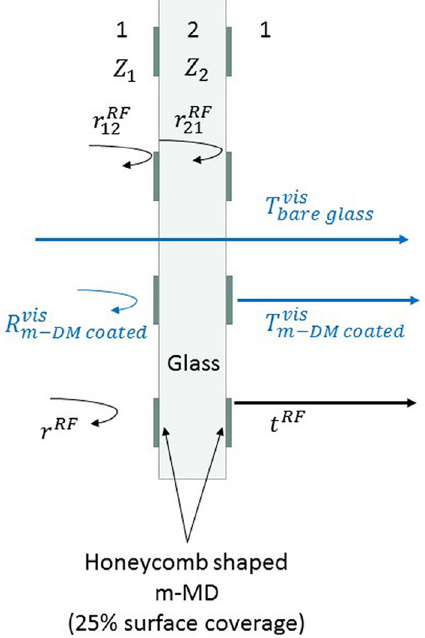
Figure2: Meta-glass(cross-sectionalview:aconceptualillustration of RF and visible performance, and RF Fresnel ’ s reflection and transmission at 28